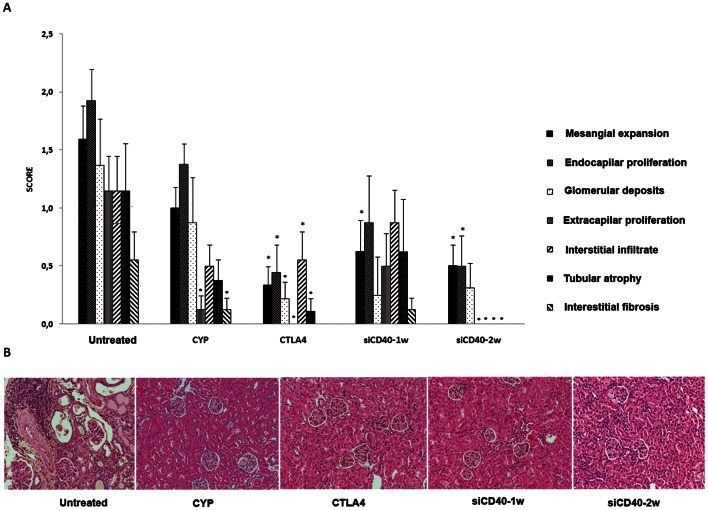
Renal histopathology.A) Costimulatory blockade reduced the elementary histological lesions of lupus nephritis. B) Representative photomicrograph (x200) of renal histology for each group. Data are expressed as mean±SEM *p<0.05 vs untreated, p<0.01 vs untreated.